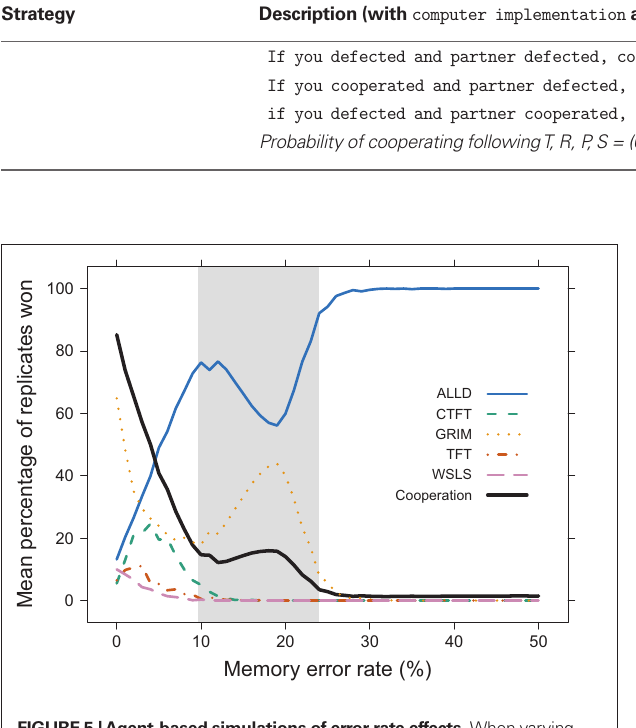
FIguRE 5 | Agent-based simulations of error rate effects. When varying error rates across a range of values, GRIM, CTFT, TFT, WSLS, and ALLD survived with few errors (we do not show strategies with success rates lower than 0.05%). At higher rates (e.g., error rates observed in the experiment are shaded), however, ALLD and GRIM outperformed the other strategies. The proportion of cooperative choices made by all agents in the last generation decreased rapidly with increasing error